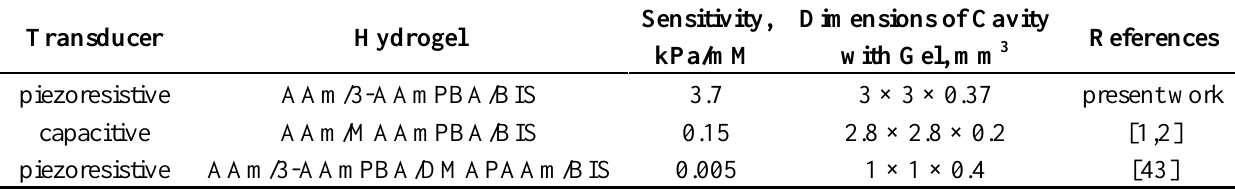
Table 3. Parameters of microfabricated implantable glucose